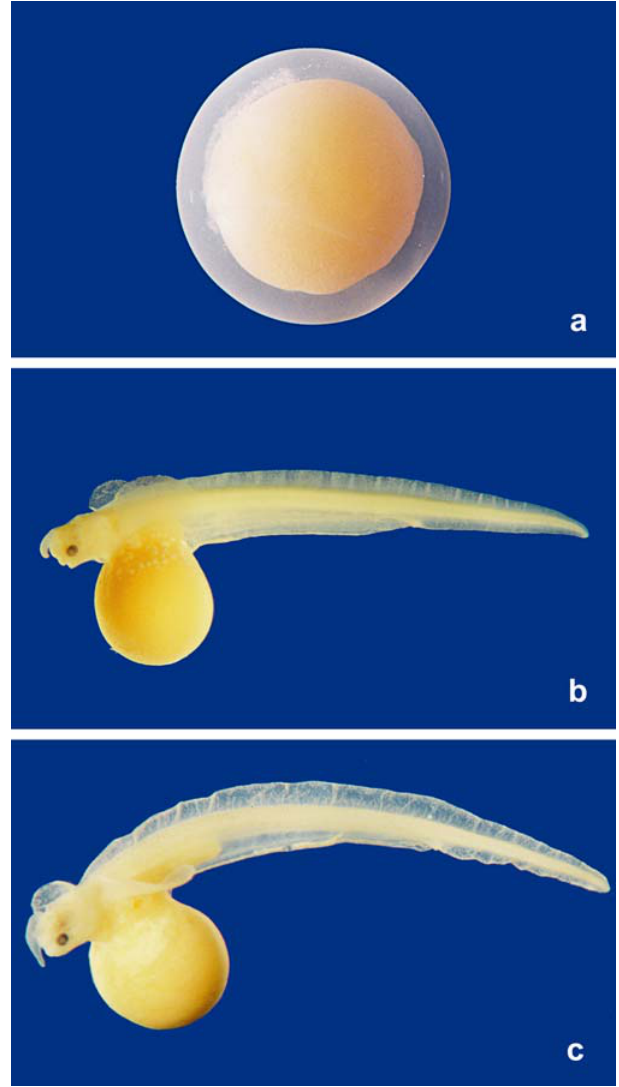
Fig. 5 . Eggs and larval stages of Synbranchus lampreia . (a) egg in Stage A; (b) larva in Stage C; (c) larva in Stage D, general